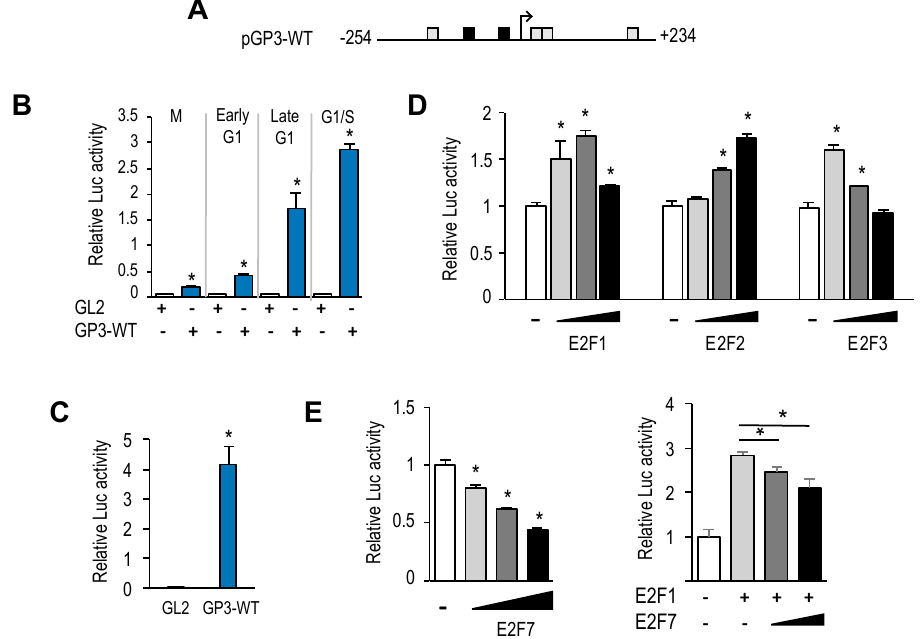
Figure 3. GOLPH3 gene is regulated by E2F factors at the transcriptional level. ( A ) Promoter-luciferase construct of GOLPH3 . The nucleotide positions of the promoter construct are numbered relative to the transcription start site. ( B ) Activation of GOLPH3 promoter-driven firefly luciferase reporter construct during the cell cycle. U2OS cells were transfected with pGP3 wild type construct (pGP3-WT) or pGL2 empty construct along with pRL-TK. Cells were subsequently synchronized in mitosis with Thy-Noc, and released into the cell cycle. Values are represented as firefly luciferase activities relative to Renilla luciferase activities of each sample. ( C ) Activation of GOLPH3 promoter-driven construct in asynchronous cells. Asynchronously growing U2OS cells were transfected with pGP3-WT construct or pGL2 empty construct along with pRL-TK. Values are represented as firefly luciferase activities relative to Renilla luciferase activities of each sample. ( D ) Ectopic E2F1-3 expression induces GOLPH3 promoter activity. Asynchronously growing U2OS cells were transfected with pGP3-WT and increasing amounts of E2F1-3 (50 ng, 150 ng, 250 ng) per well in a 12-well plate. Values are represented as luciferase activities relative to pGP3-WT activity of cells transfected with empty pCMV control. ( E ) Ectopic E2F7 expression represses GOLPH3 promoter activity. Asynchronously growing U2OS cells were transfected with pGP3-WT and increasing amounts of E2F7 (50 ng, 150 ng, 250 ng) in the absence (left panel), or in the presence of E2F1 co-expression (150 ng). Values are represented as luciferase activities relative to pGP3-WT activity of cells transfected with empty pCMV control. Shown are the results of a representative experiment of three independent experiments. *, p <